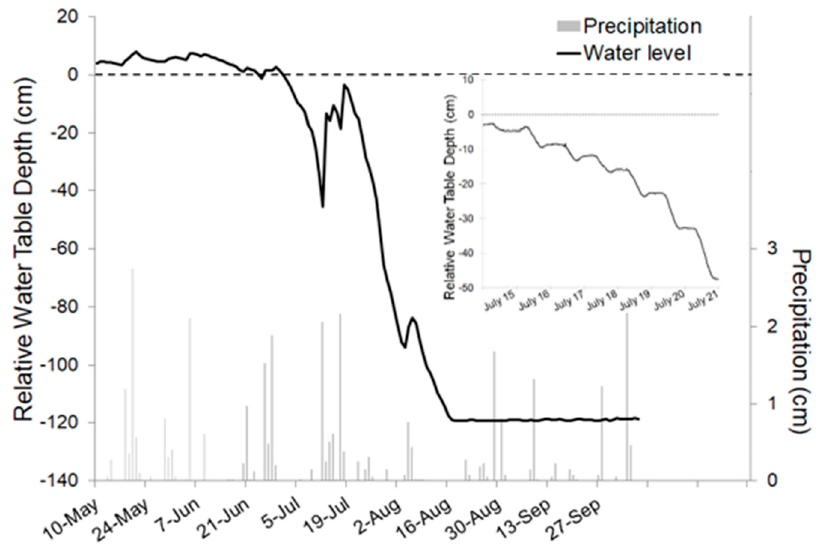
Figure 3. Water table hydrograph for a black ash wetland in northern Minnesota (classified as WFn64 based on Aaseng et al. [25]). Water tables are above the soil surface following spring snowmelt, and then rapidly drawdown once black ash leaf expansion occurs (usually in mid-June). The influence of black ash transpiration on this pattern is readily apparent in the diurnal water table pattern once water tables are below the soil surface (inset).